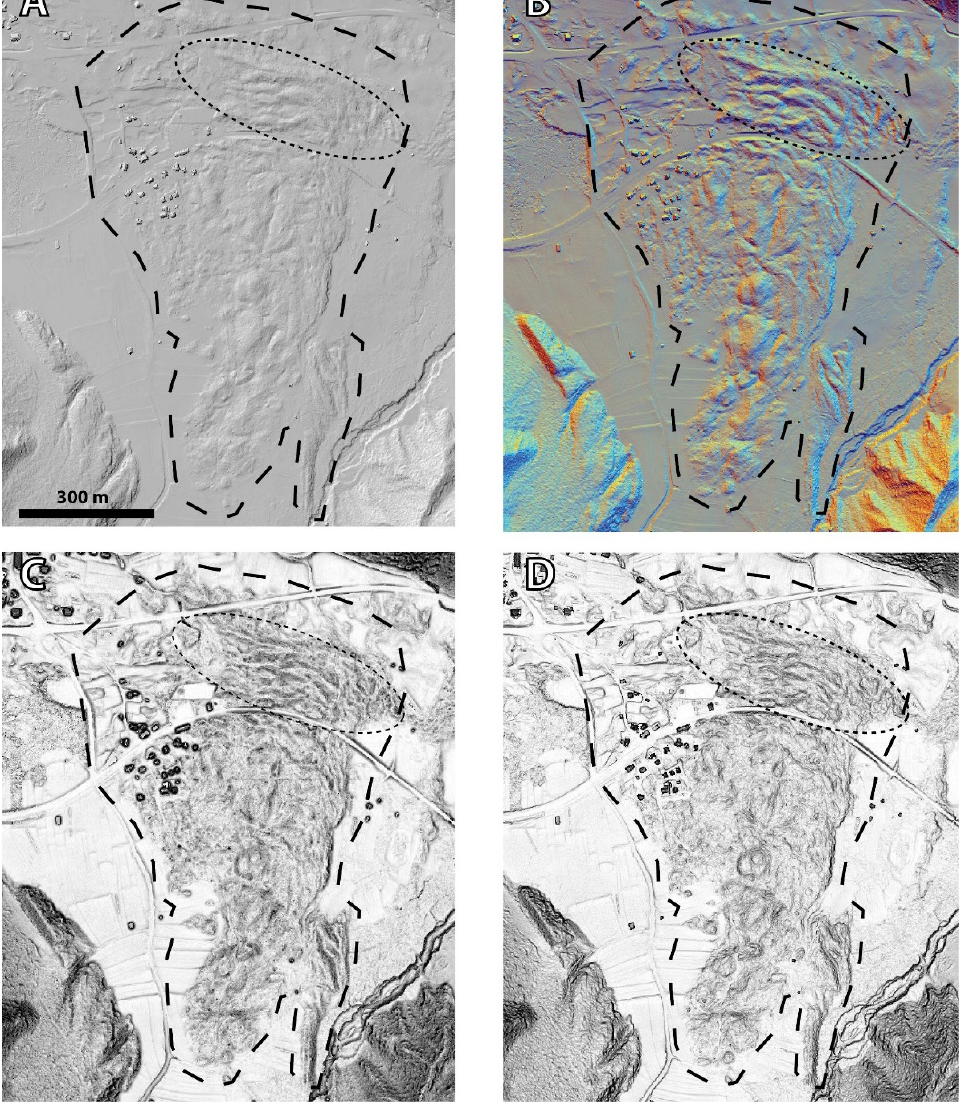
Figure 7. Glacial deposits located at the valley entrance (dashed line). End moraine ridges orientated in NW-SE direction are marked by the oval dashed line. Square shaped object in the northwest corner and approximately left of the image centre are buildings and not boulders. ( A ) Analytical hillshading (A315, H35), ( B ) hillshading from multiple directions RGB (D16, H35), ( C ) 8-bit sky view factor, and ( D ) 8-bit slope visualisations. For location see rectangle 7 in Figure 1.